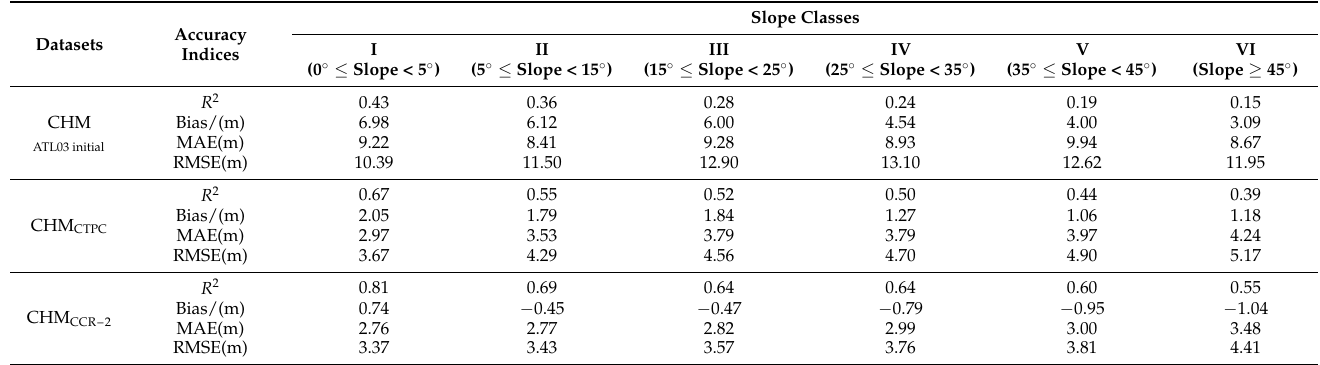
Table 6. The influence of different slopes on the canopy height estimation